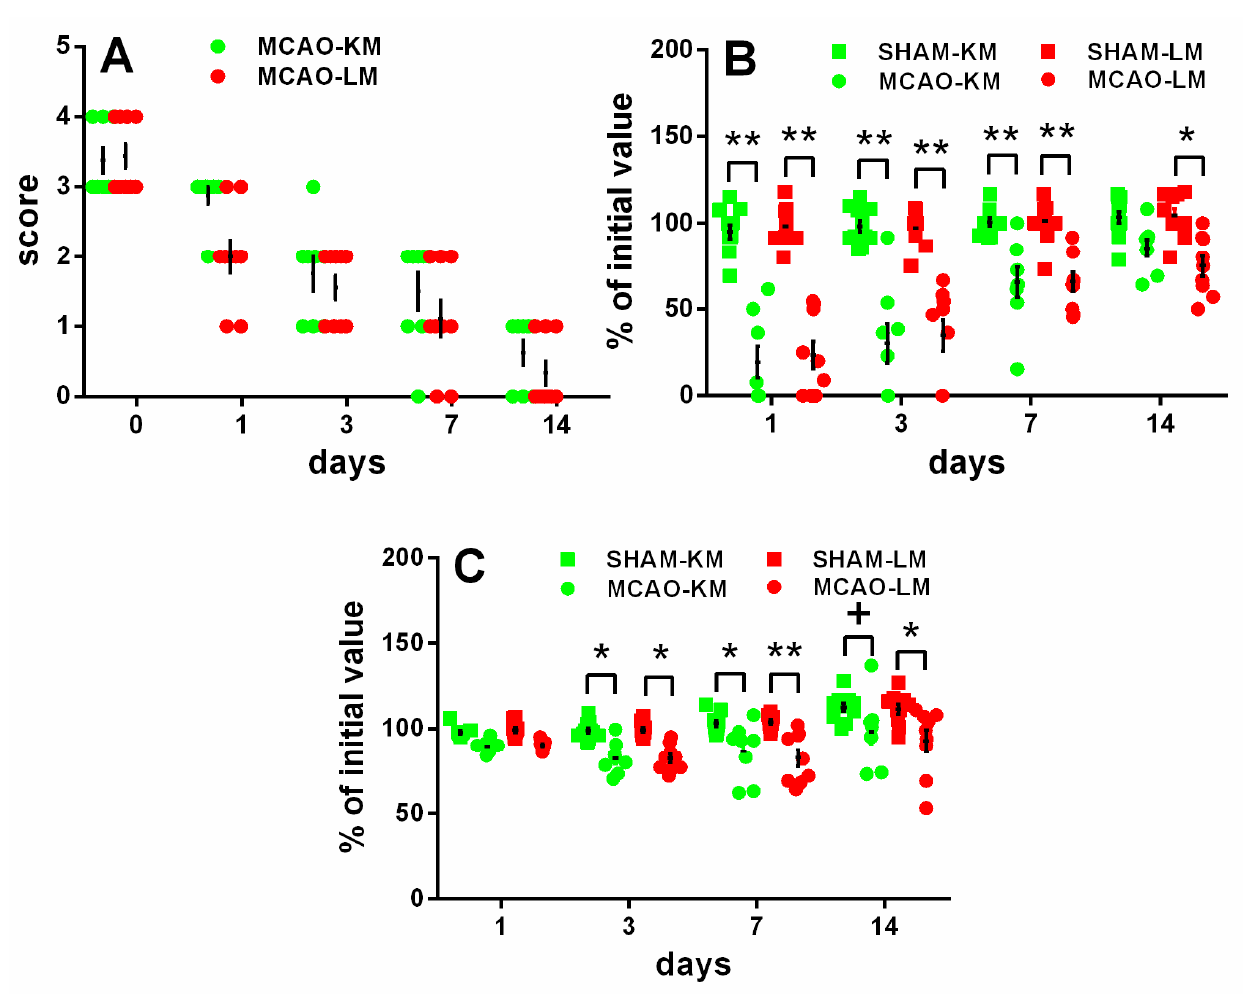
Figure 2. Time course of neurological deficits ( A , B ) and body weight loss ( C ) in MCAO-KM, MCAO-LM, and respective sham groups during 14 days after surgery. ( A ) 5-score test after surgery 0, 1, 3, 7, and 14 days after surgery. ( B ) Tongue protrusion test 1, 3, 7, and 14 days after surgery; % of initial values. ( C ) Body mass 1, 3, 7, and 14 days after surgery; % of initial mass. ** p < 0.01, * p < 0.05, + p < 0.1 compared with the respective sham-operated groups.